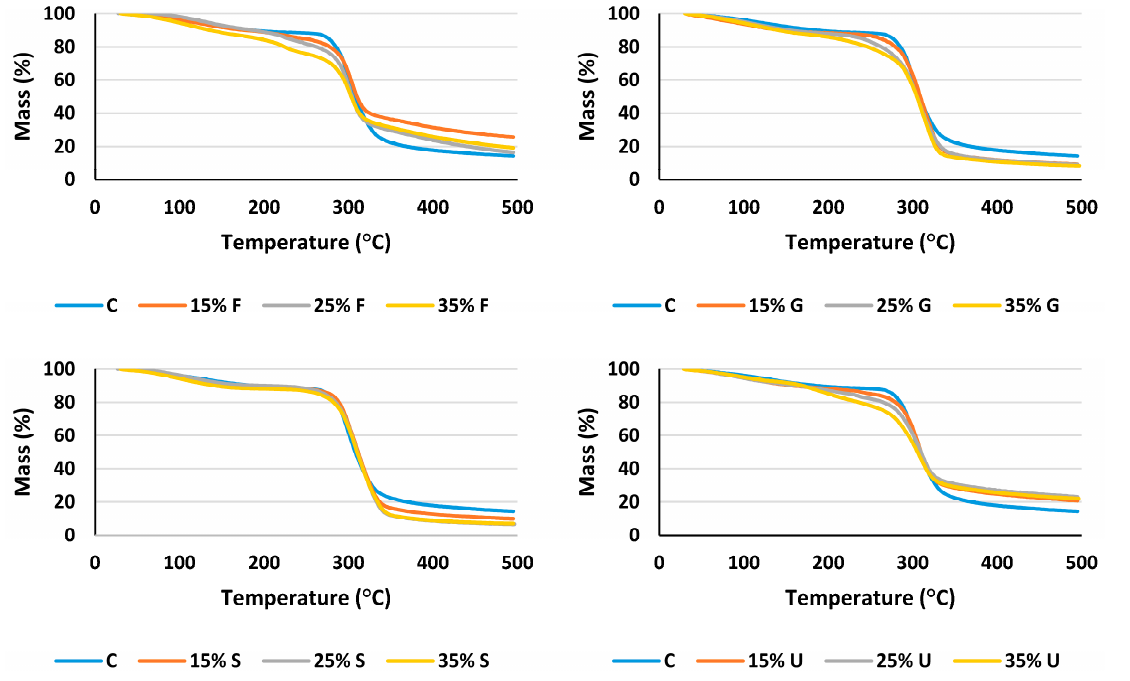
Figure 7. TGA curve of wheat starch plasticized films with various plasticizer types and concentra- tions.